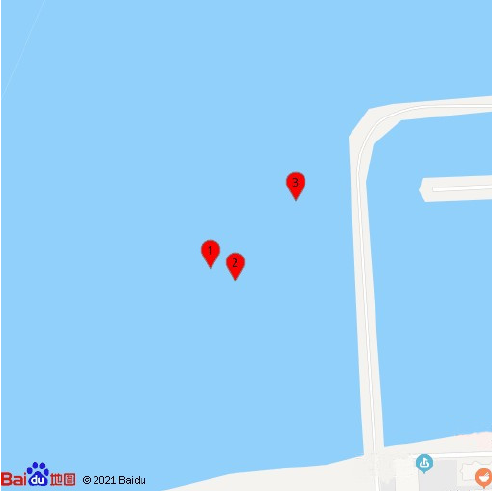
Figure 11. Platforms GPS